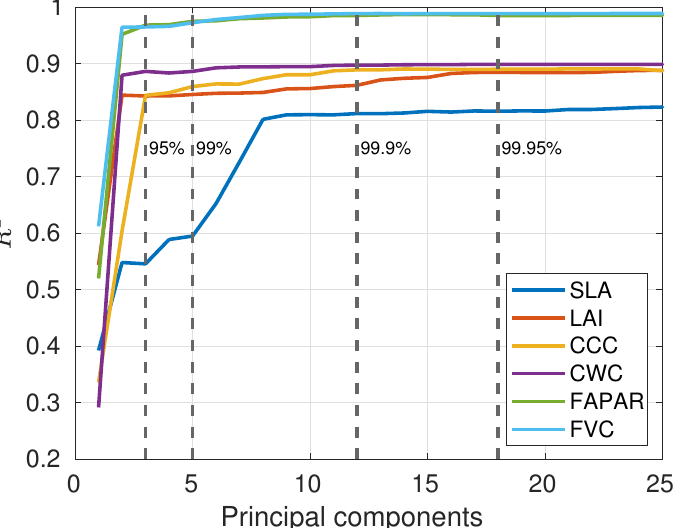
Figure 4. Theoretical retrieval accuracy ( R 2 ) for all six variables achieved by GPR-20PCA models as a function of the number of components, shown from one to 25 (afterward, no more change is visible). A random training-testing data split of 70–30% was applied. Vertical lines represent the traits-averaged cumulative variance covered by the principal components at 95%, 99%, 99.9%, and